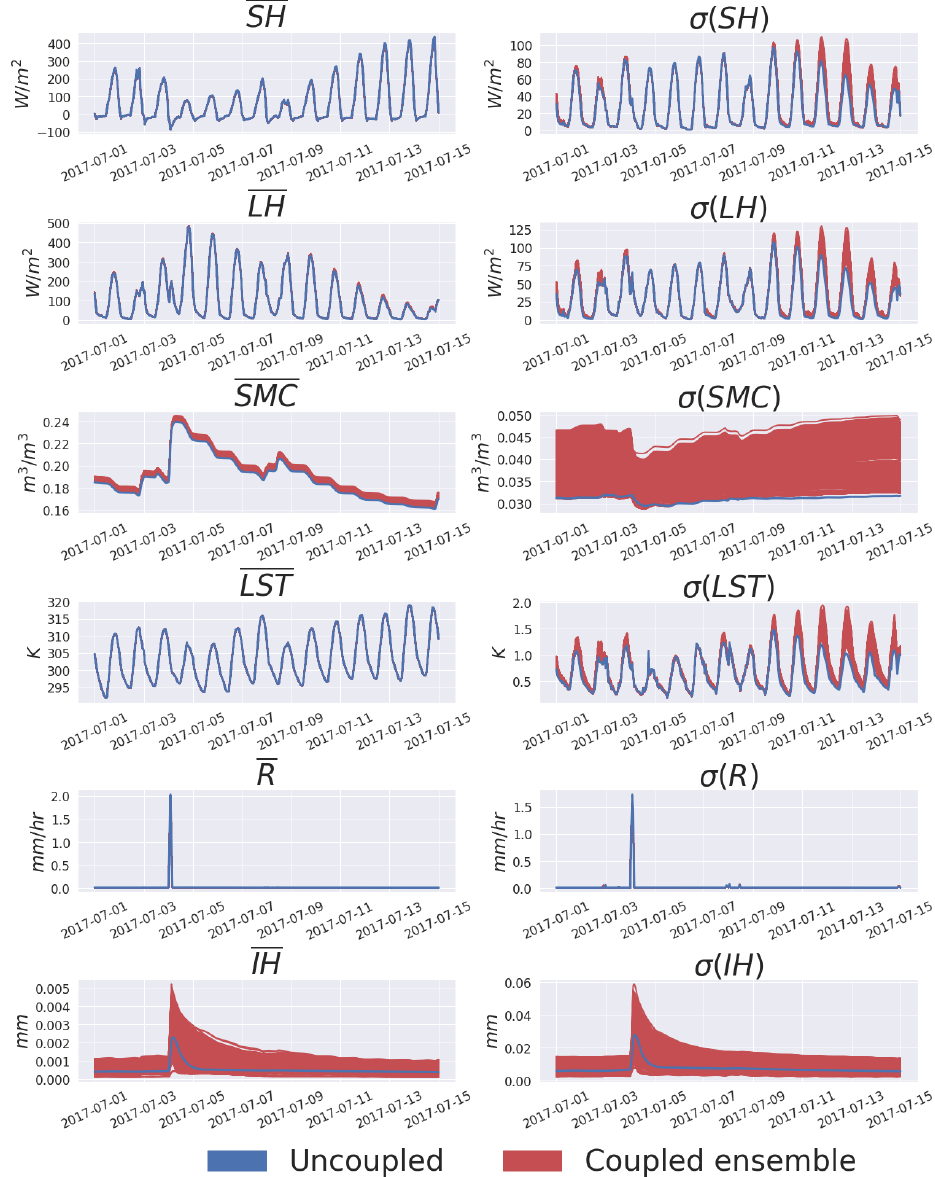
Figure 11. Ensemble spread from the Sobol sensitivity analysis of the coupled routing–land surface HydroBlocks model between 1 and 15 July 2017. The shown simulated variables include the spatial mean ( X ) and spatial standard deviation ( σ(X) ) of sensible heat flux (SH), latent heat flux (LH), root zone soil moisture (SMC), land surface temperature (LST), runoff ( R ), and inundation height (IH). For comparison, the baseline uncoupled simulation is shown in